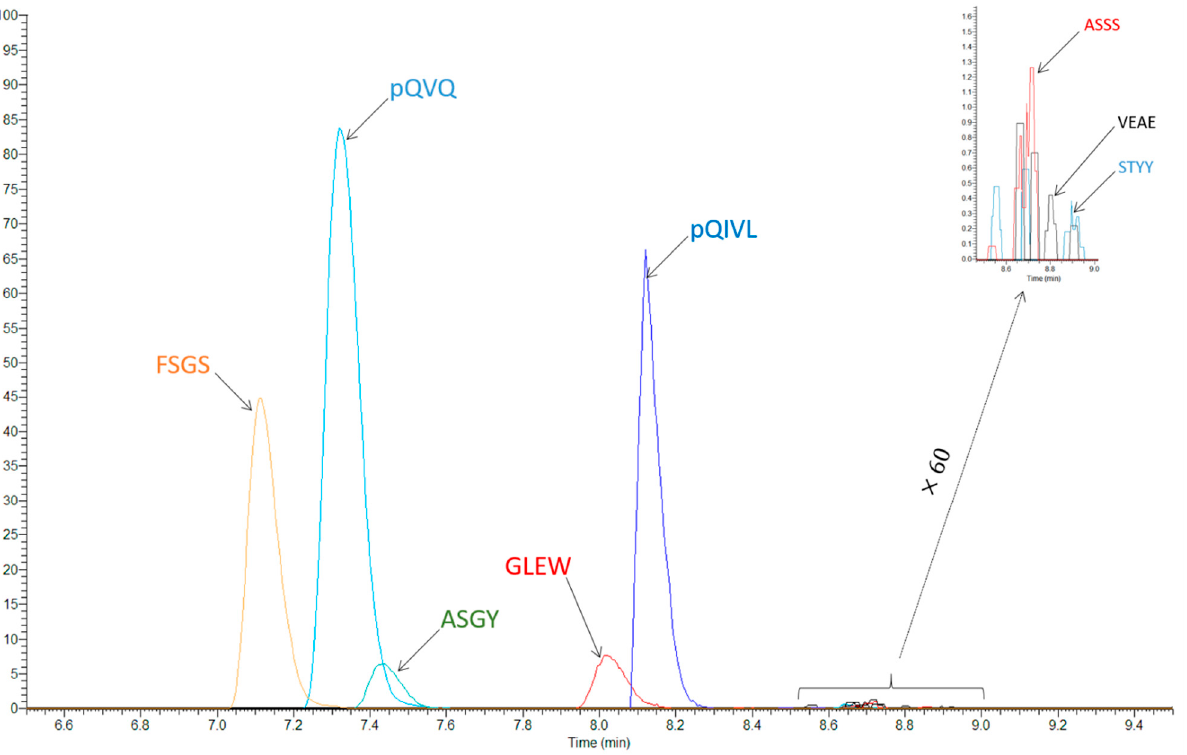
Figure 2. Liquid chromatography orbitrap tandem mass spectrometer (LC-MS/HRMS) chromatogram of proteotypic peptides obtained from a pure solution of RTX at 10 µg/mL analyzed in Full Scan Mode.